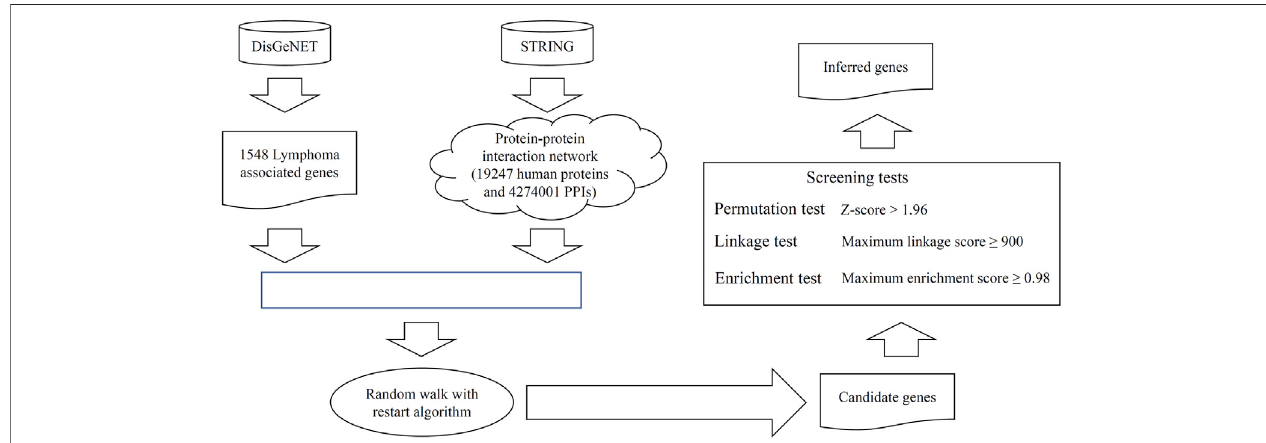
FIGURE 1 | Entire procedure to mine the novel candidate genes related to lymphoma. The validated lymphoma-associated genes were retrieved from DisGeNET. From STRING, a protein – protein interaction network was constructed. These genes and the network were fed into the random walk with restart algorithm to extract the candidate genes with high probabilities. These genes were further fi ltered by using three screening tests to select the fi nal inferred genes. The enrichment analysis is conducted on all inferred genes and some genes are analyzed individually.